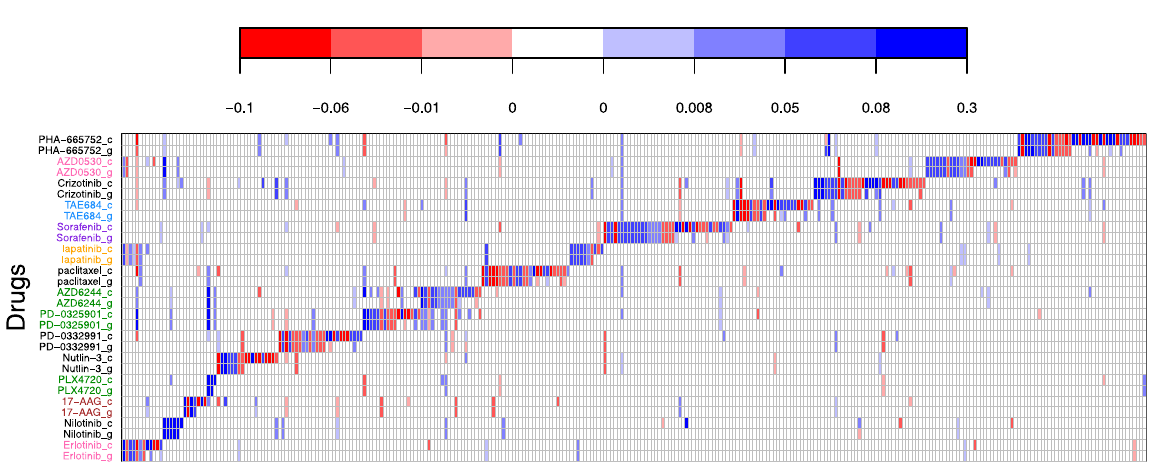
Figure 9. Signature validation plot based on GDSC (g) and CCLE (c) datasets using Formulation 1. The y-axis shows the different drugs under study. The x-axis shows the markers which had significant effects. Blue coloring indicates a positive estimated effect; red a negative estimated effect. White indicates an estimated null